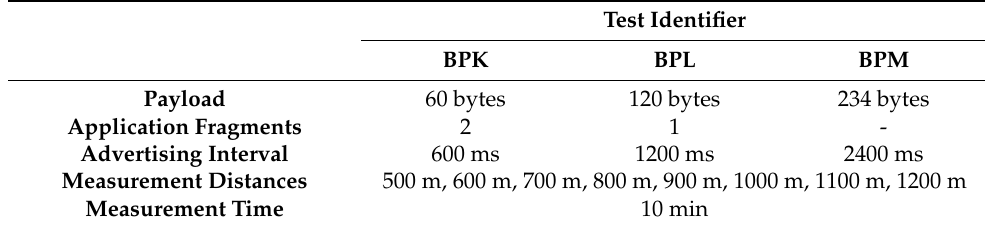
Table 4. Test configuration static I2V scenario.